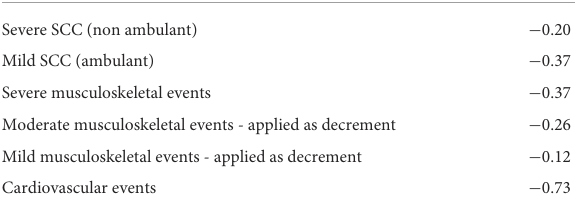
TABLE 8 Utility of adverse